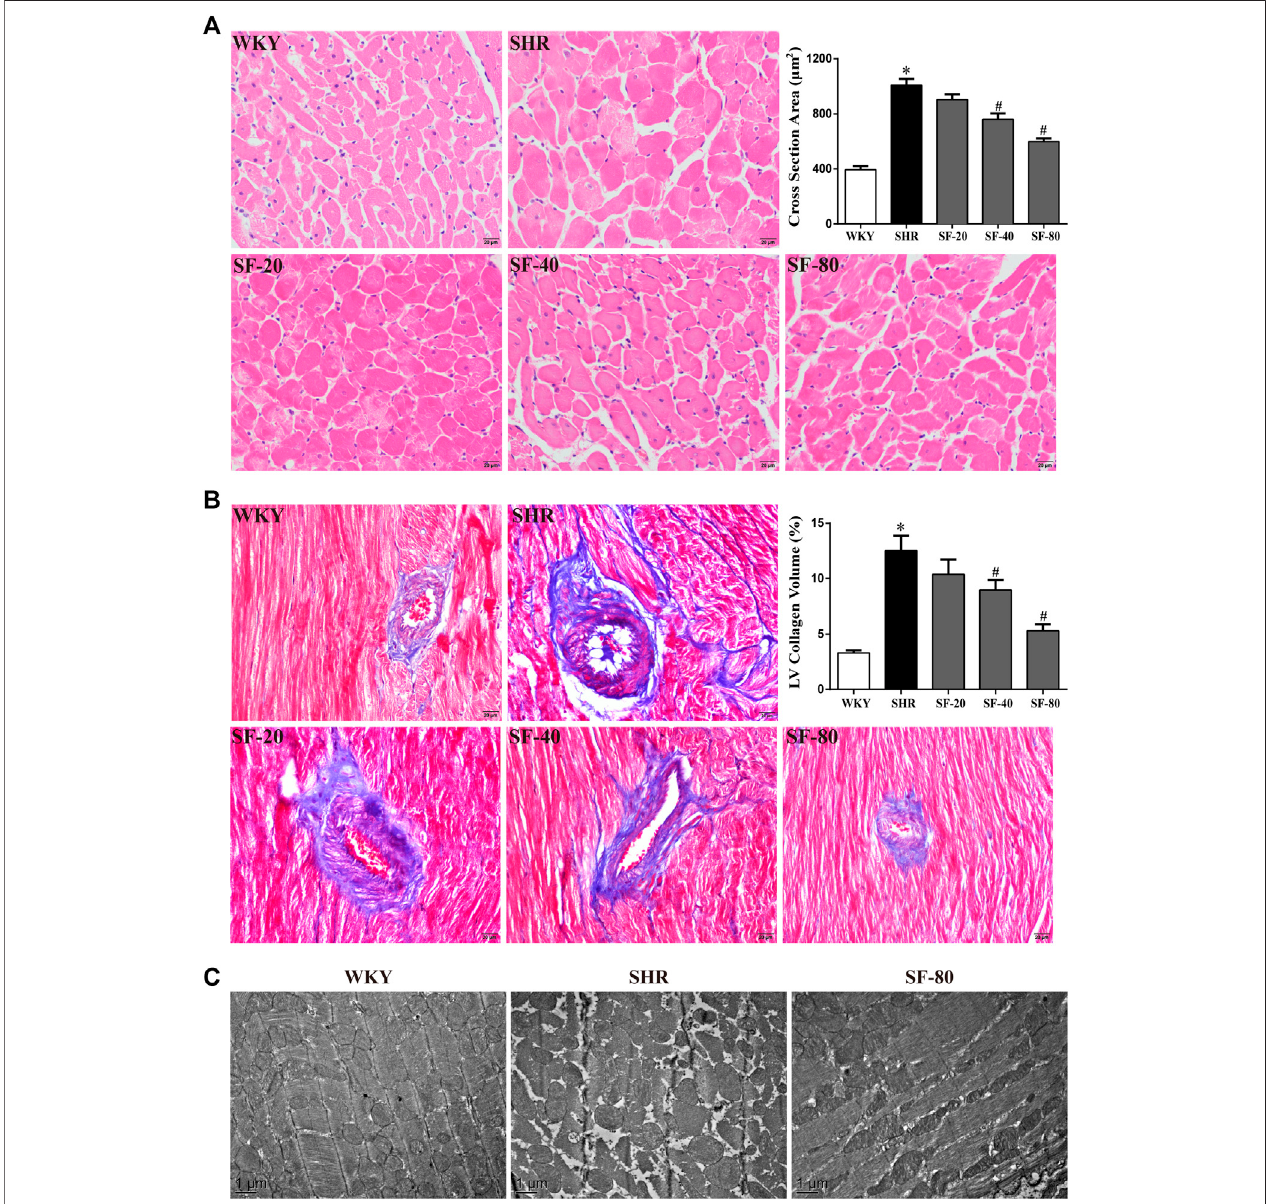
FIGURE 4 | SF can improve left ventricular histomorphology in SHRs. (A) Representative photomicrographs of transection of myocardial tissue in rats (scale bar (cid:1) 20 μ m). ( n (cid:1) 5). (B) representative photomicrographs of collagen deposition of myocardial tissue in rats (scale bar (cid:1) 20 μ m). ( n (cid:1) 5). (C) representative photographs of ultrastructure of myocardial tissue in rats (bar (cid:1) 1 μ m). SF signi fi cantly inhibited the increase of cardiomyocytes and the deposition of collagen fi bers and improved the ultrastructure of cardiomyocytes. Data are presented as mean ± SEM. *signi fi cantly different from WKY at p < 0.05; # signi fi cantly different from SHRs at p < 0.05.